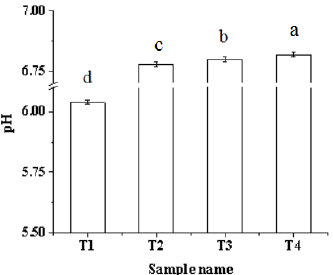
Figure 1. Effects of ultrasound-assisted sodium bicarbonate treatment on the pH of raw pork myofibrillar protein. T1, sodium bicarbonate 0 g, ultrasound time 0 min; T2, sodium bicarbonate 0.2 g, ultrasound time 0 min; T3, sodium bicarbonate 0.2 g, ultrasound time 30 min; T4, sodium bicarbonate 0.2 g, ultrasound time 60 min. Each value represents the mean ± SE, n = 4. a–d Different parameter superscripts indicate significant differences ( p <